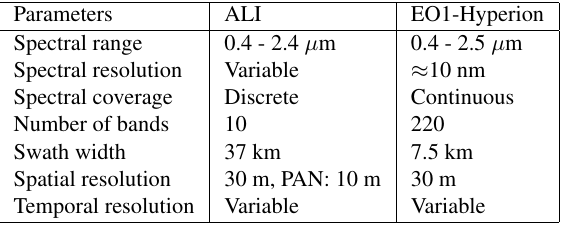
Table 1: ALI and Hyperion technical